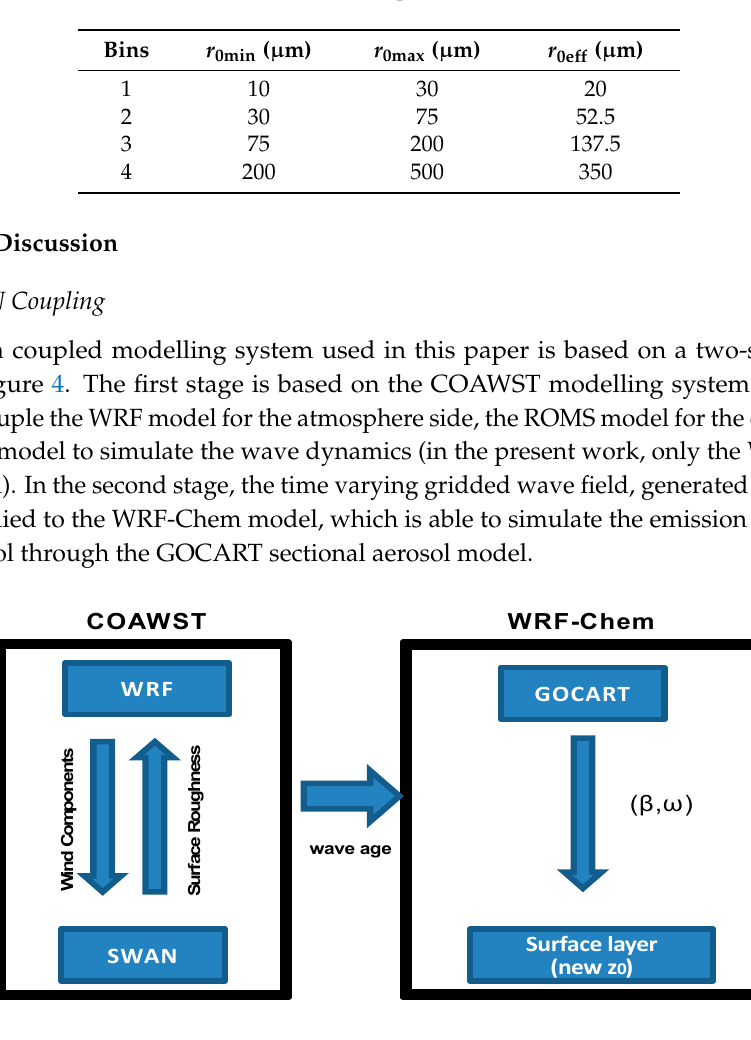
Figure 4. Schematic representation of the coupled modelling system.